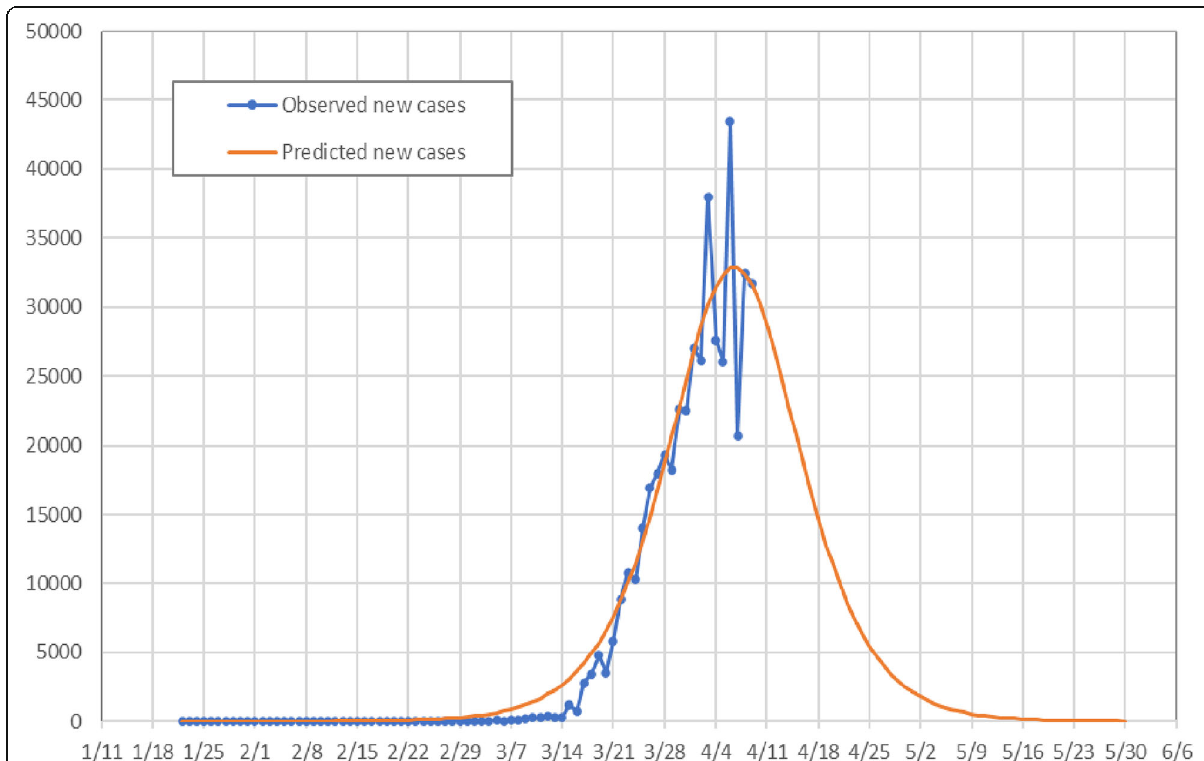
Fig. 1 Observed vs. model-estimated and forecasted daily new COVID-19 cases, January 22 – May 30,